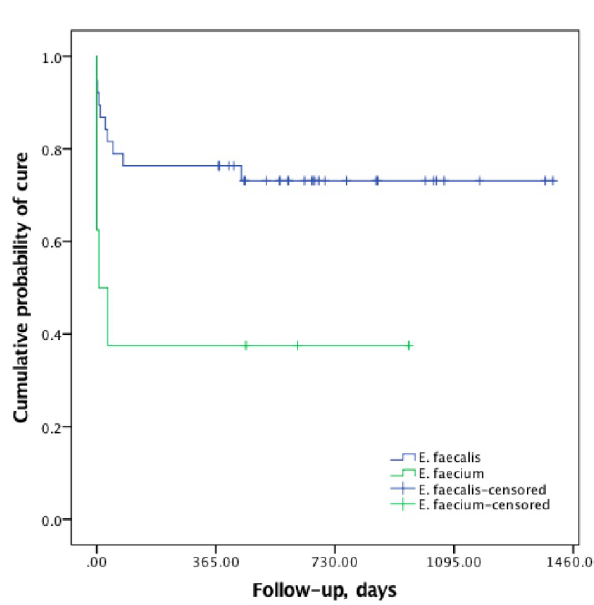
Figure 3. Kaplan-Meier curve of cumulative probability of cure according to enterococcal species (Log-rank test p